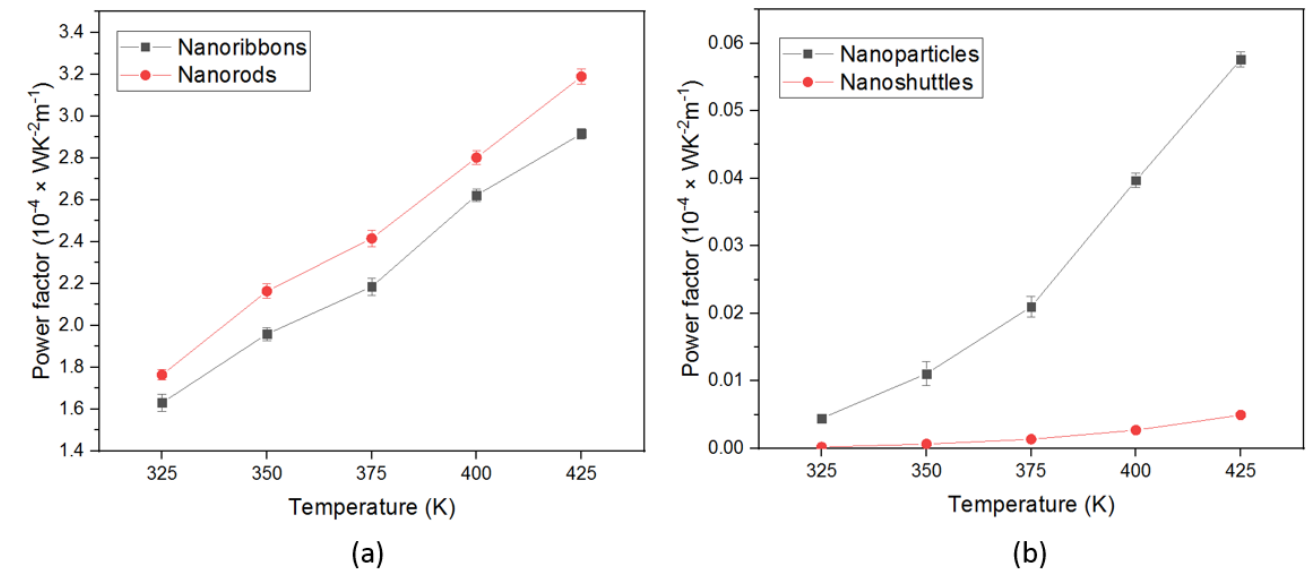
Figure 7. Temperature-dependent power factor of ZnO nanostructures ( a ) nanoribbons, and nanorods, ( b ) nanoparticles, and nanoshuttles. The thermoelectric figure of merit ( ZT ) of four different ZnO nanostructures are shown in Figure 8. The ZT values represent the efficiency of the thermoelectric material (Equation